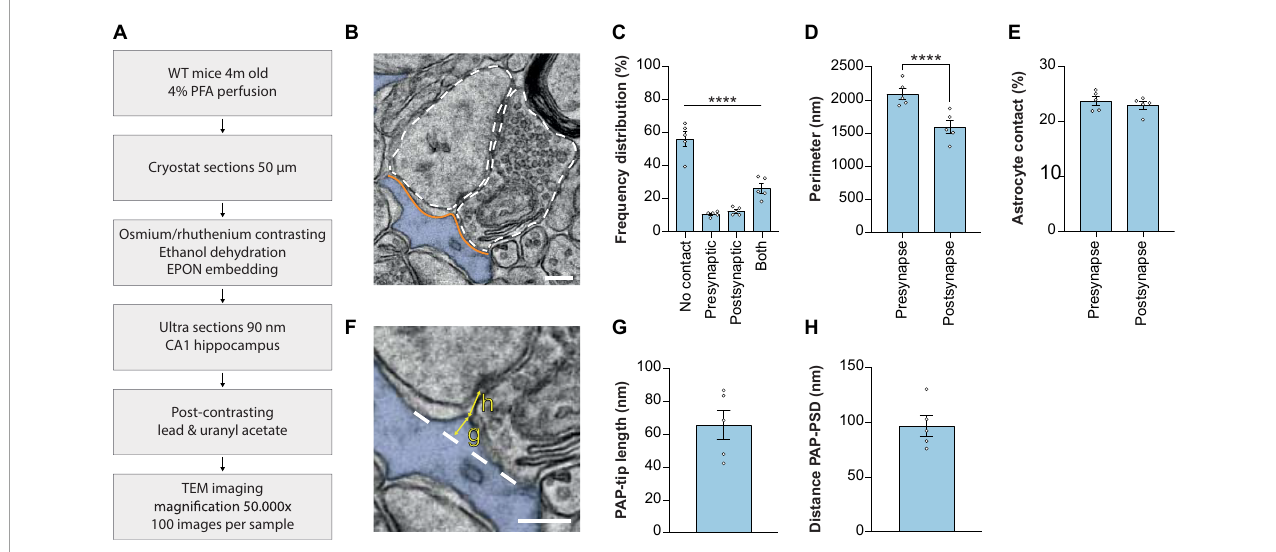
FIGURE1 Measuring synaptic ultrastructure and astrocyte interactions by 2D EM analysis in mouse hippocampus CA1. (A) Schematic illustration of the methods used. (B) Example 2D EM image of a synapse in mouse hippocampus CA1. The outline of the pre-synaptic and post-synaptic membranes is indicated with a dashed line. The astrocyte is pseudo-colored in blue. Orange lines indicate the membrane interaction between pre-synapse and post-synapse with the astrocyte. (C) Frequency distribution plot showing the percentages of presence of contact types between synapse and astrocyte. (D) Perimeter of the pre-synapse and post-synapse. (E) Contact between astrocyte and pre-synapse or post-synapse, relative to the pre-synapse or post-synapse perimeter, respectively. (F) Example of measurement of PAP tip length (G) and distance between the PAP-tip and PSD (H) . The base of the protruding part of the PAP-tip is indicated with the dashed line. (G) Quantification of the PAP-tip to PSD distance. (H) Quantification of the astrocyte PAP tip length. Data is presented as mean SEM. *** P ≤ 0.0001. PAP, perisynaptic astrocytic process; PSD, post-synaptic density. Scale bars are 300 nm n = 5/441. Statistical details are reported in Supplementary Table 1 .